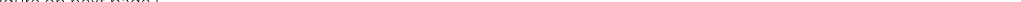
(See figure on next Fig. 10 a Vertical displacement (cid:31) z versus time (5-point running averaged) of the H ≃ 20 cm, L = 13.5 cm cliffs. Hydraulic head h w varies in the range of h w = 1.8 –15 cm (numbers annotated). Solid (broken) lines indicate the cases in which the slides were triggered (not triggered). (cid:31) indicates the (cid:31) z at the T slide , which is defined from the threshold velocity v 0 (see b ). b Vertical velocity v z versus time (5-point running averaged) calculated from a using the runs in which a slide was triggered. (cid:31) indicates the T slide defined at the threshold v 0 = 0.1 mm/s. c T seep ( (cid:31) ) and T slide ( (cid:31) ) versus h w of the H ≃ 20 cm cliffs (see Additional file 4: Fig. S5 for a semi-log version). The upper horizontal axis is in the h w / H scale. Solid and broken curves indicate the T seep calculated by solving Eq. (10) using 2 permeability ( k ) values: k 1 = 5.0 × 10 − 11 m 2 and k 2 = 1.8 × 10 − 11 m 2 . d T seep , ≃ 2 cm (see Additional file 4: Fig. S6 for the (cid:31) z vs. time plot). There are no measurements of T h T w slide versus H for a constant not triggered (3 runs), sensor data acquisition stopped (1 run); see Table 2 legend). The 2 horizontal lines indicate the T seep calculated for h w = 2 cm using the same k 1 and k 2 values used in c